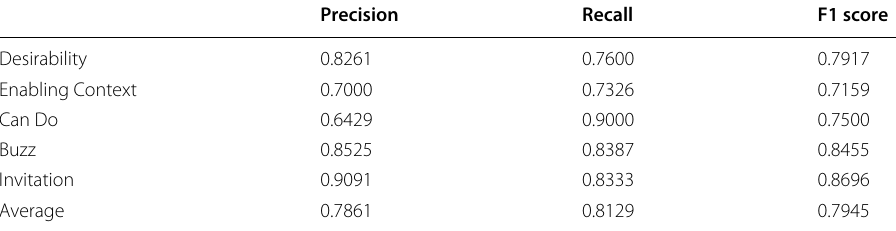
Table 10 Results for BERTweet stacking ensemble scenario SE#11